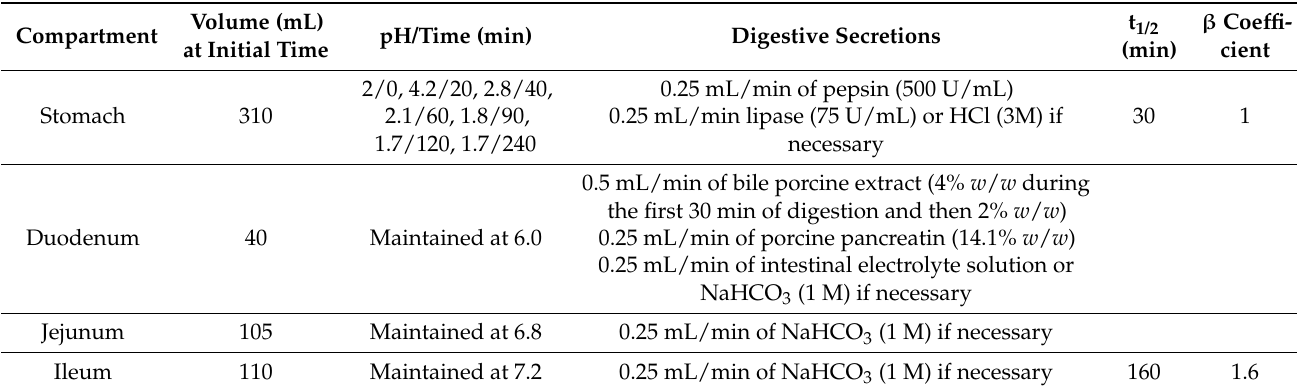
Figure 2. Overview of R ‐ IVET experiments in the three complementary human gut models. Table 2. Parameters of TIM-1 gastrointestinal model used to simulate milk digestion by a healthy human adult (adapted from